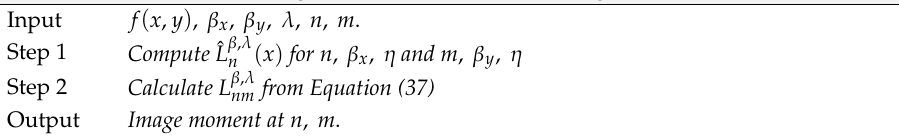
Algorithm 4: Generalized Laguerre Fractional Order Orthogonal Moments (FGLMs) [21]